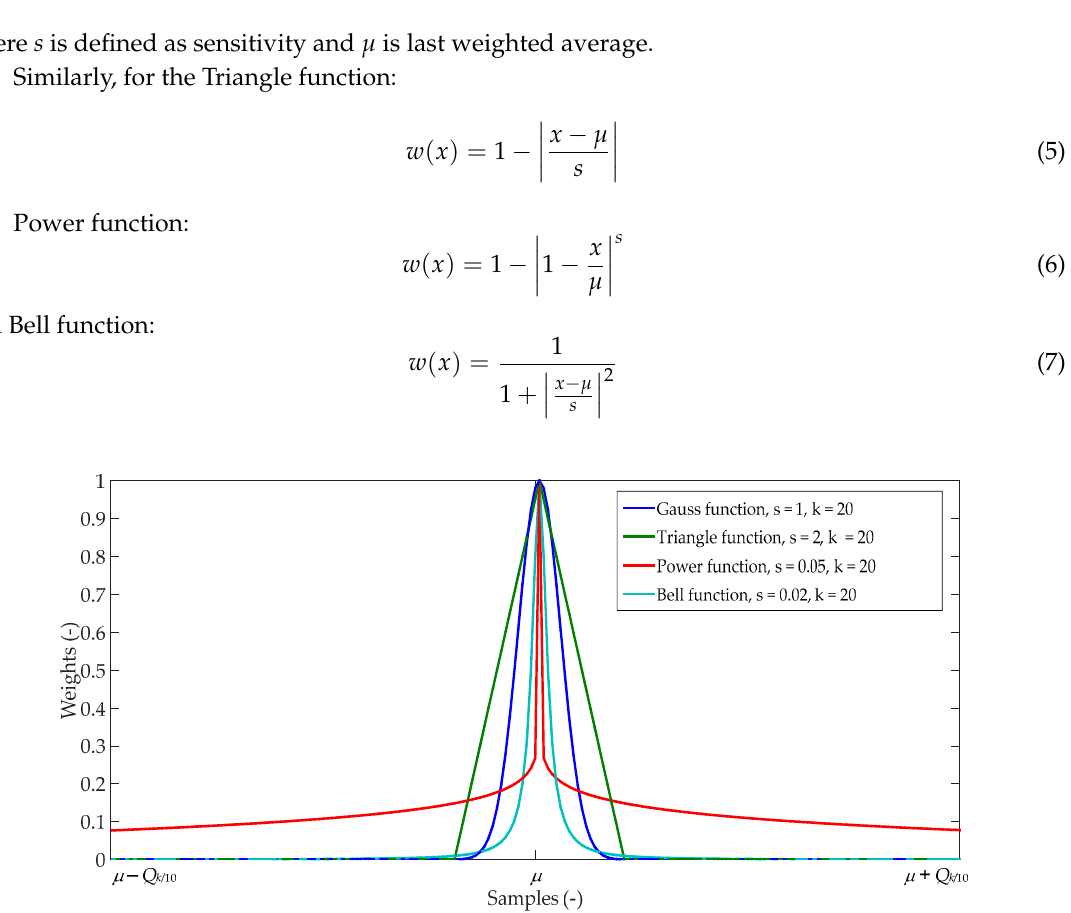
Figure 2. Examples of membership functions.